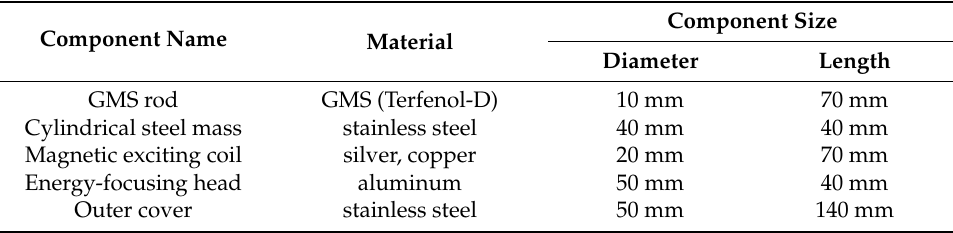
Table 1. Materials in the components of the GMS actuator.